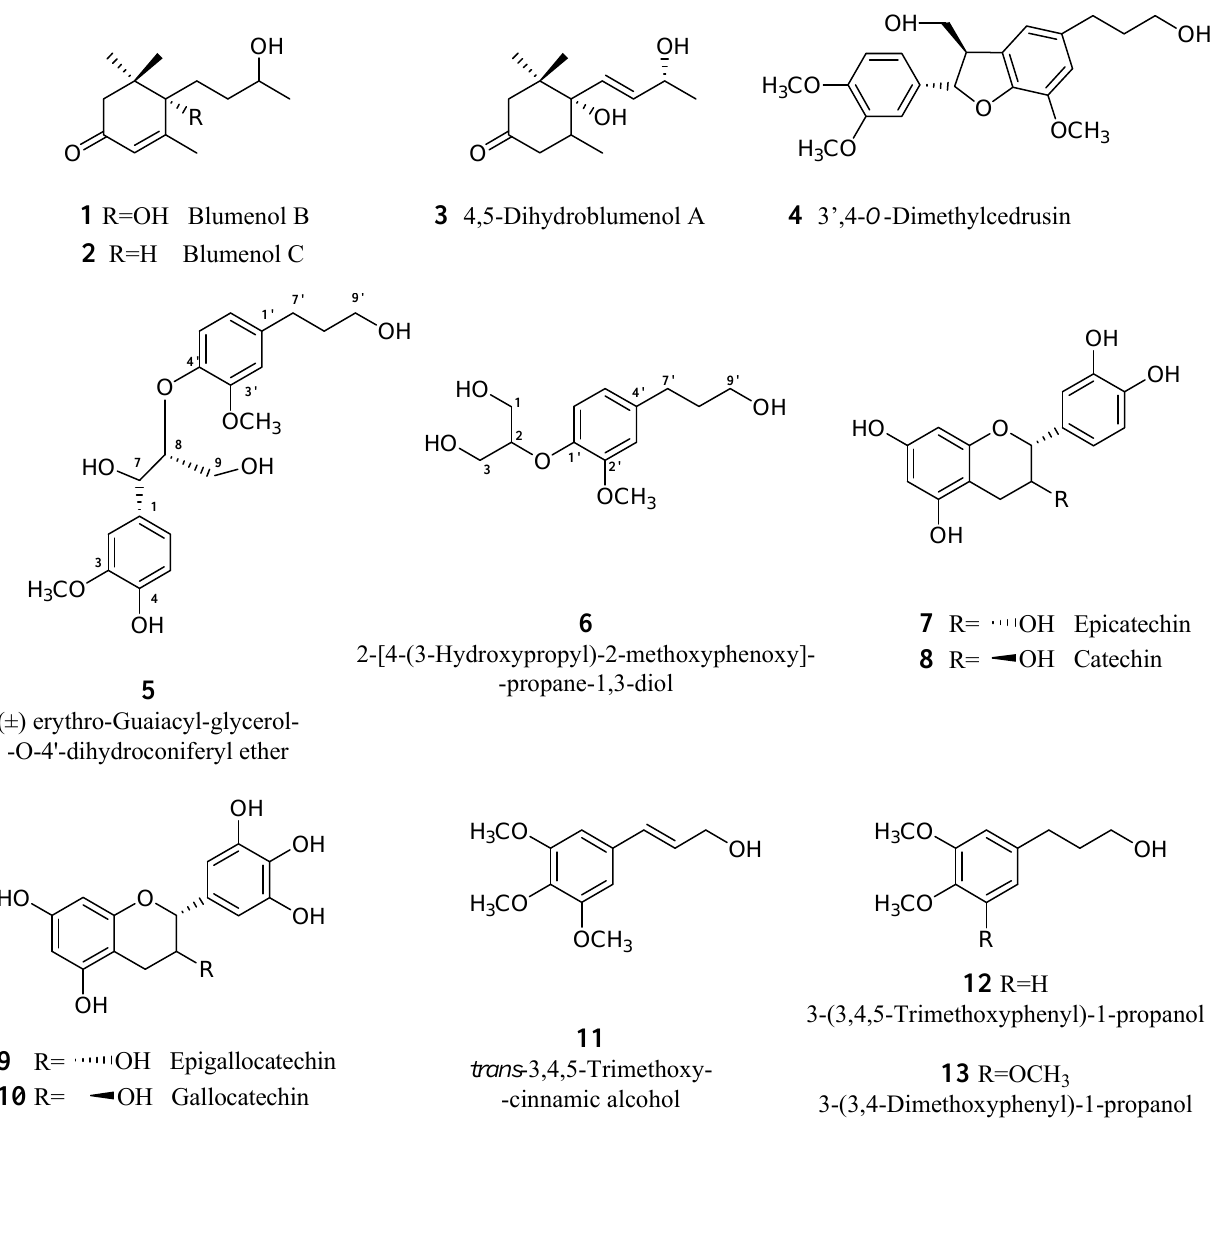
Figure 1. Secondary metabolites isolated from the latex of Croton lechleri (Muell-Arg).